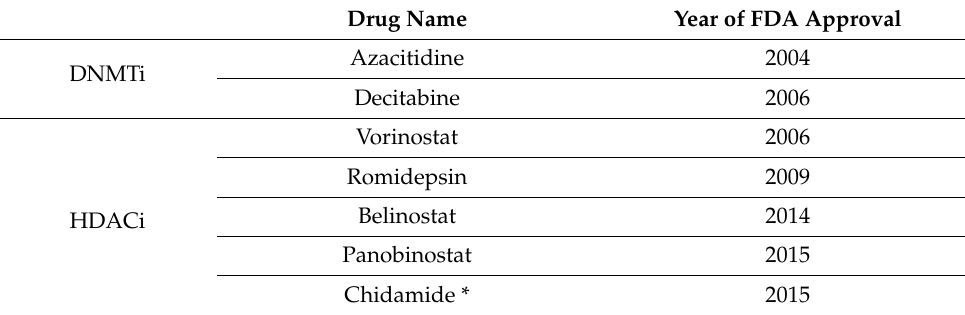
Table 3. The timeline of DNMTi and HDACi FDA approval. * China’s FDA